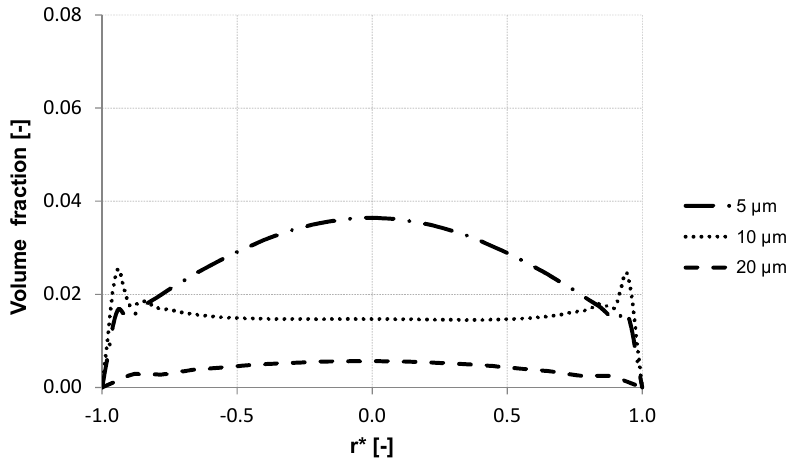
Figure 13. Particle distribution along control line C with different particle size after 5 s (homogeneous initial distribution, backwashing flux of 300 L m − 2 h − 1